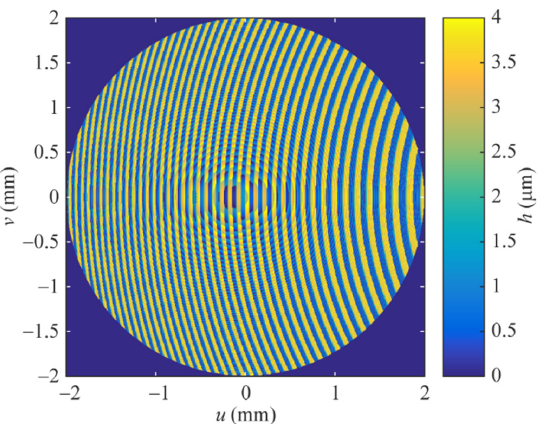
Figure 3. Microrelief of the MWDL focusing the wavelengths λ 1 = 900 nm and λ 2 = 970 nm to two points.